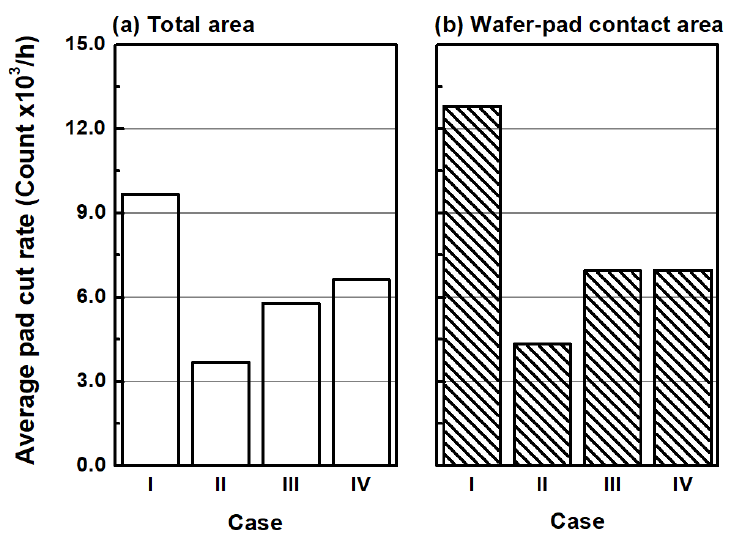
Figure 8. Average pad cut rate of conditioning cases: ( a ) total area and ( b ) wafer–pad contact area.